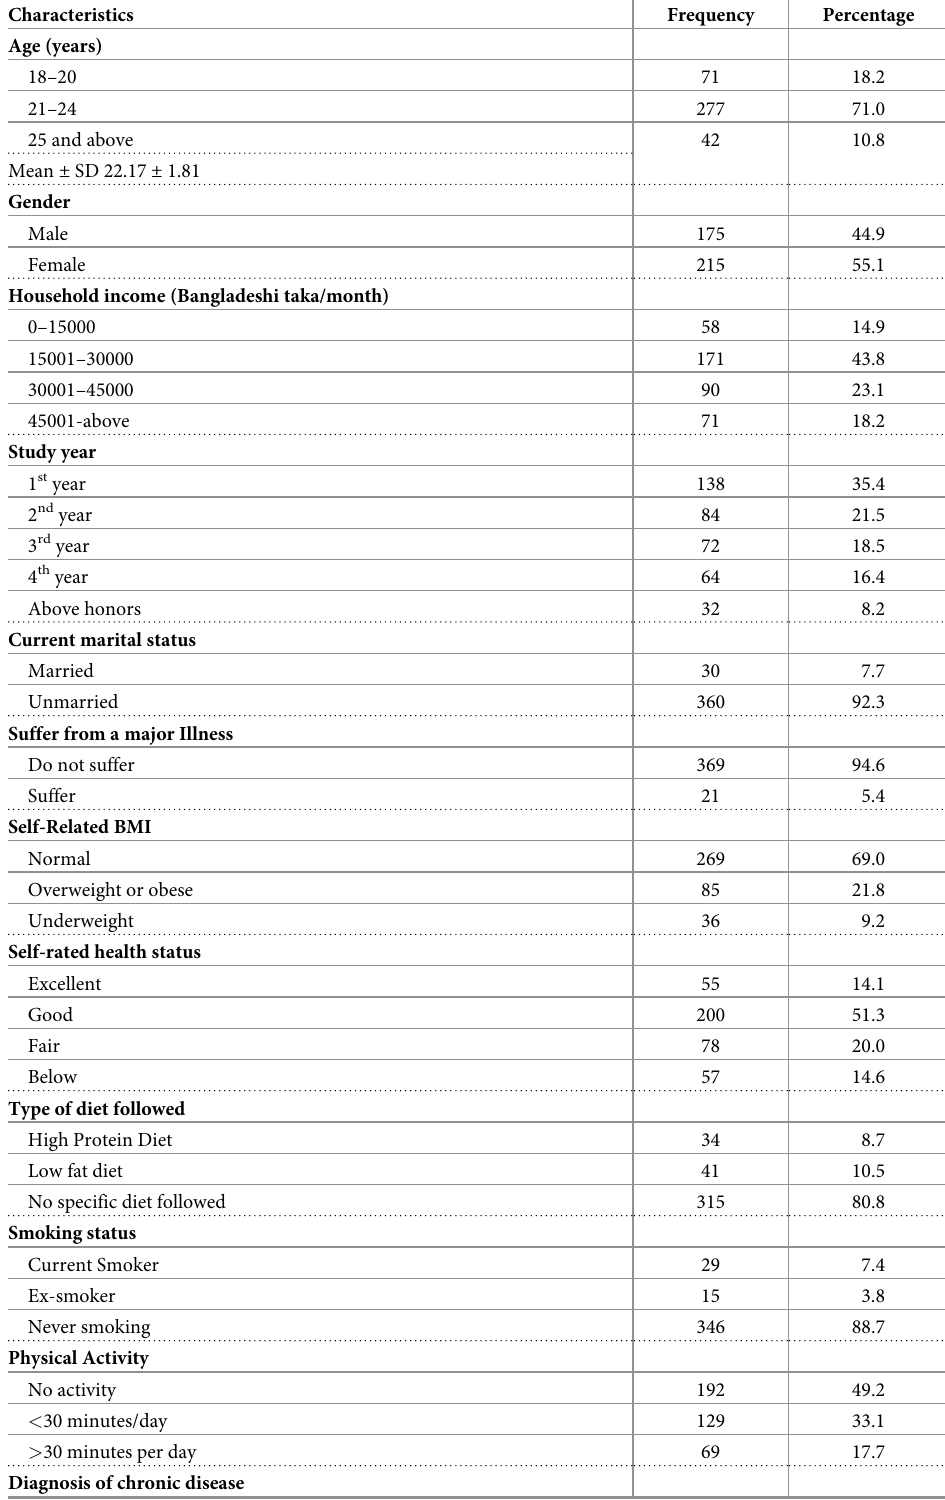
Table 1. Socio-demographic, behavioral and diet-related characteristics of study participants (N = 390).